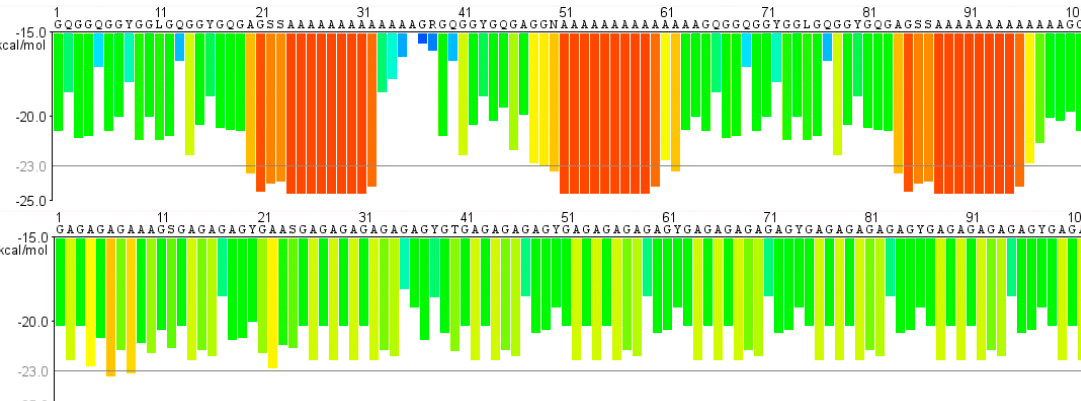
Figure 4. Fibrillation propensity profiles of the first 100 amino acid residues of B. mori fibroin heavy chain repetitive part (AF226688.1) ( top ) and three repetitive blocks from E. australis MaSp1 (GenBank AM490183) ( bottom ). The amino acid residues are presented in one-letter format above each plot. The energies are color-coded, blue and green representing higher energies while orange and red represents lower energies that are deemed to have high fibrillation propensity. Profiles generated by ZipperDB [93].